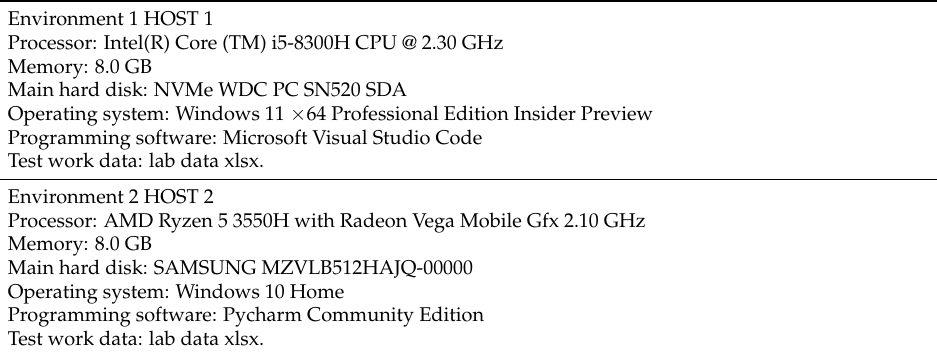
Table 4. The details of experiment environment.